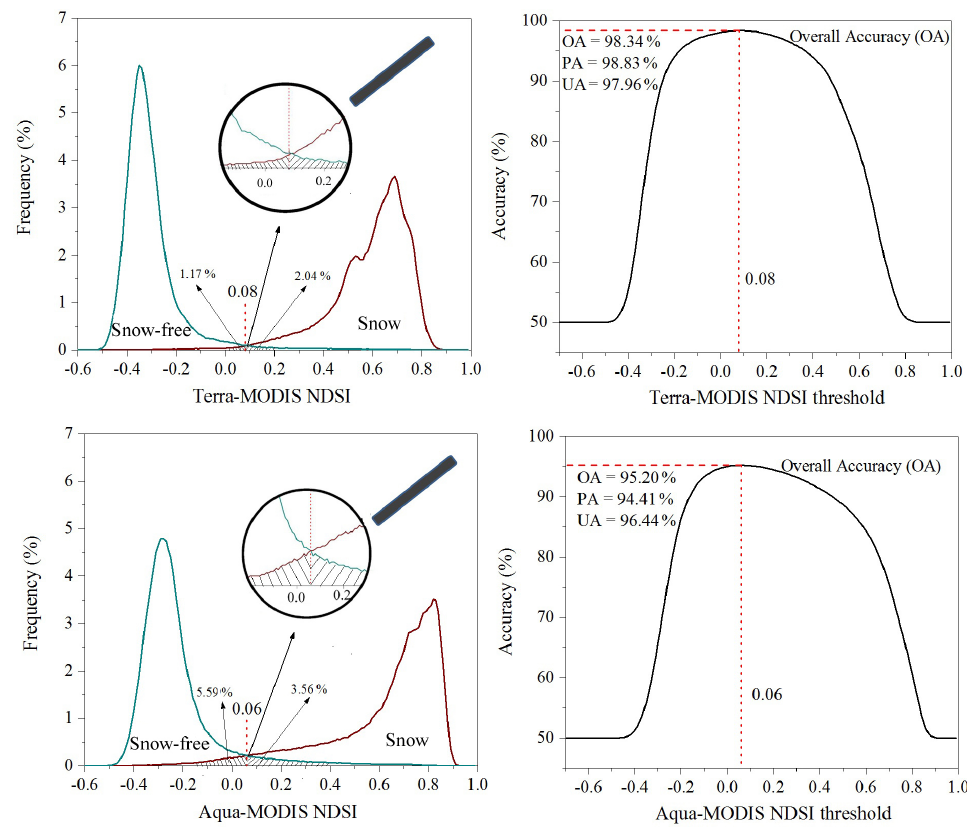
Figure 2. Optimal NDSI thresholds over the land-cover type of “barren or sparsely vegetated”.